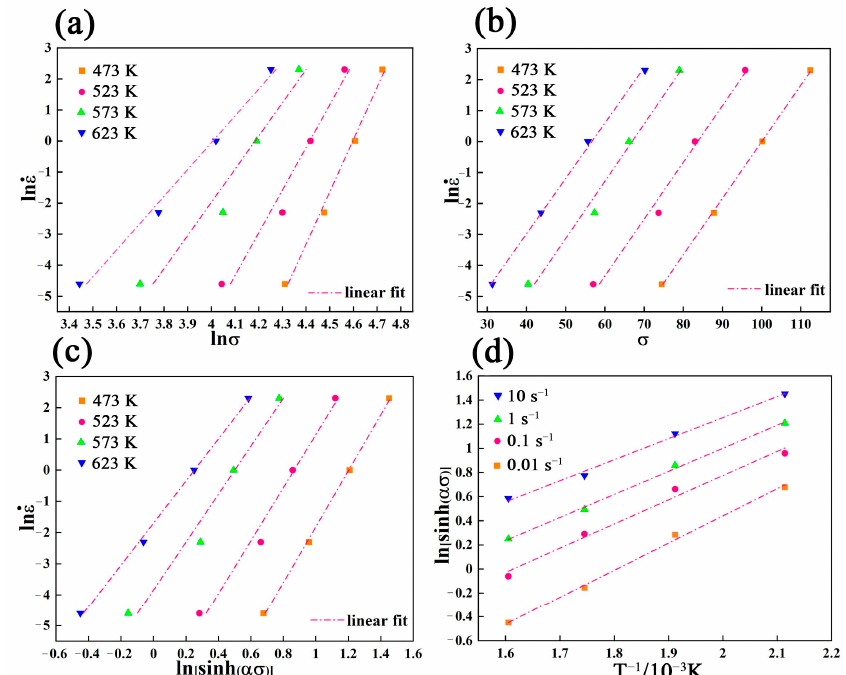
. . . ε -ln σ , ( b ) ln ε - σ , ( c ) ln ε -ln [ sinh ( ασ )] and